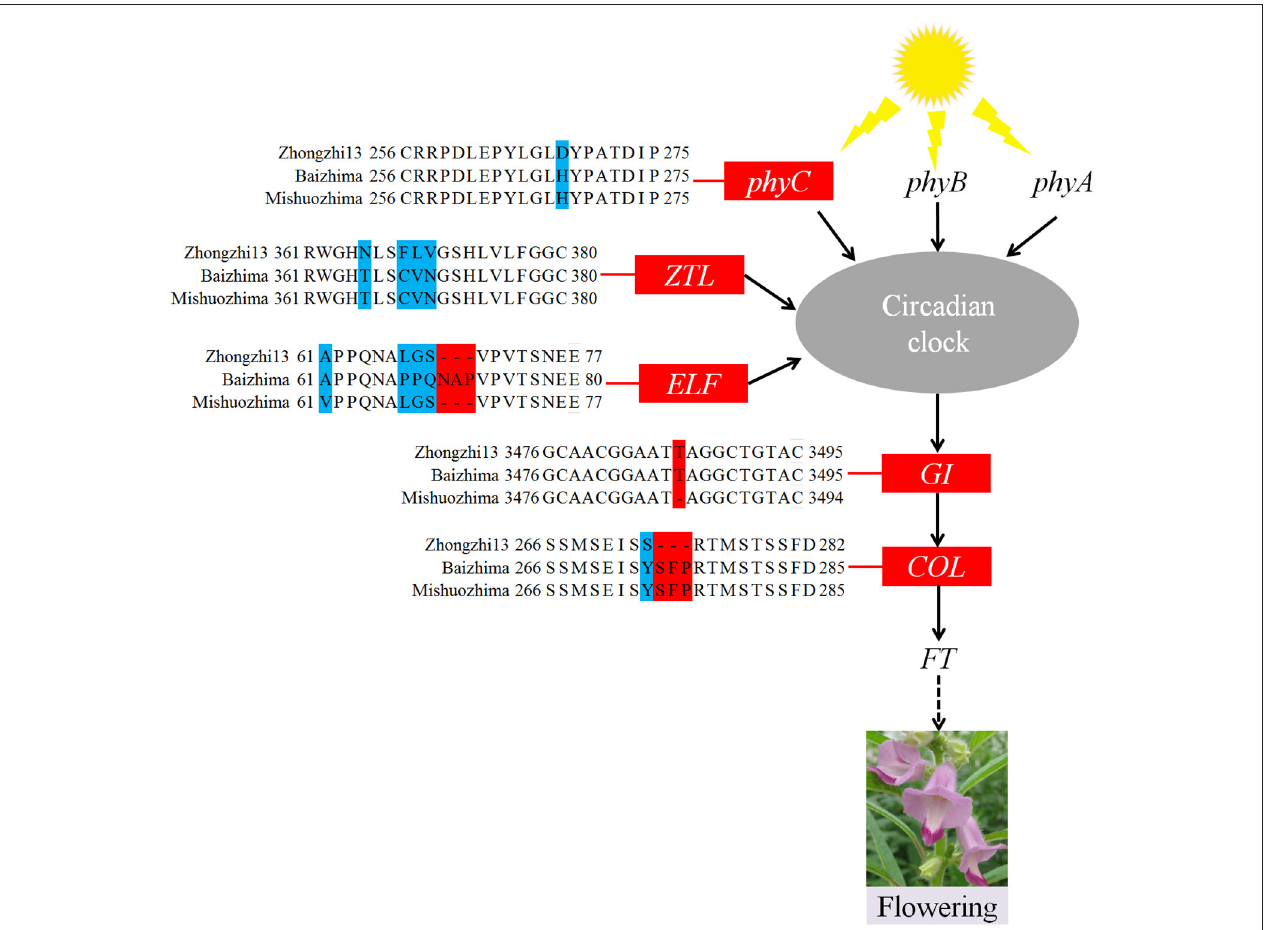
FIGURE 4 | Variations in photoperiod genes of sesame. In phyC , ZTL , ELF, and COL , amino acid changes resulting from SNPs and InDels are shown. In the GI gene, a 1 bp insertion was found in “Zhongzhi13” and